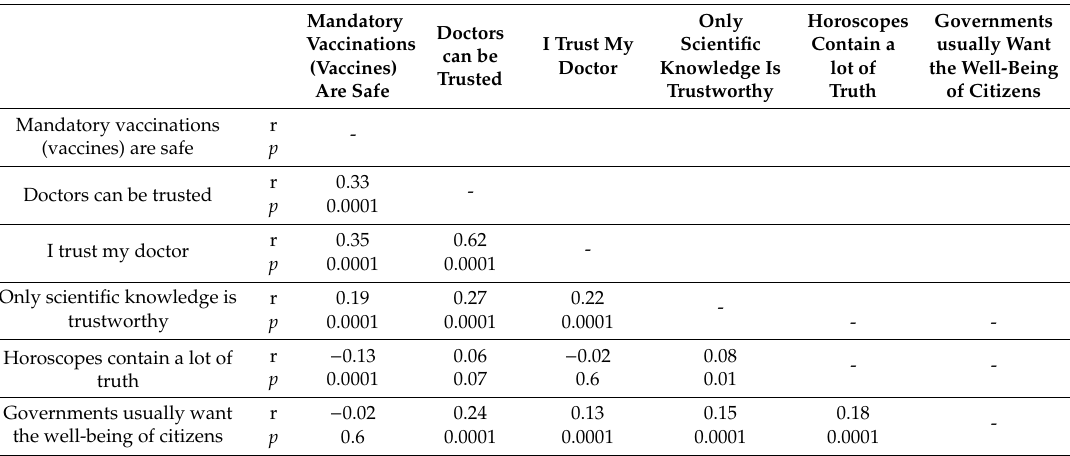
r—The Spearman rank correlation coe ffi